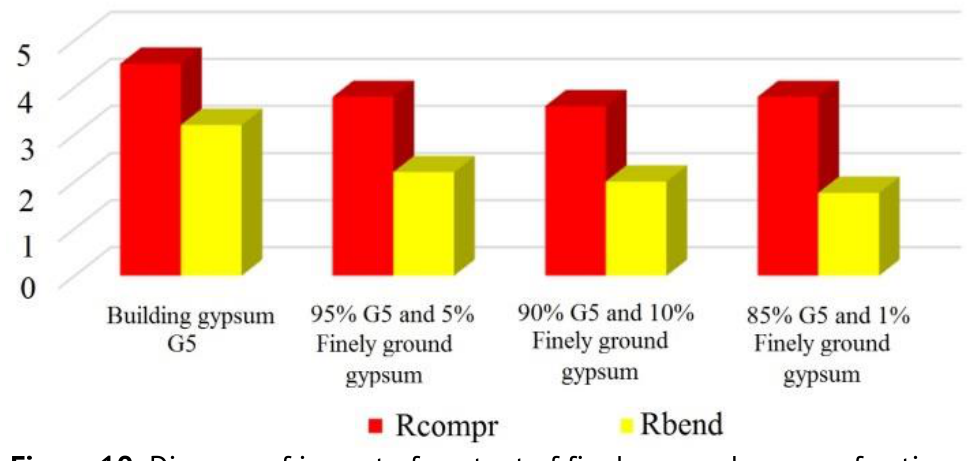
Figure 10. Diagram of impact of content of finely ground gypsum fractions on the strength of gypsum